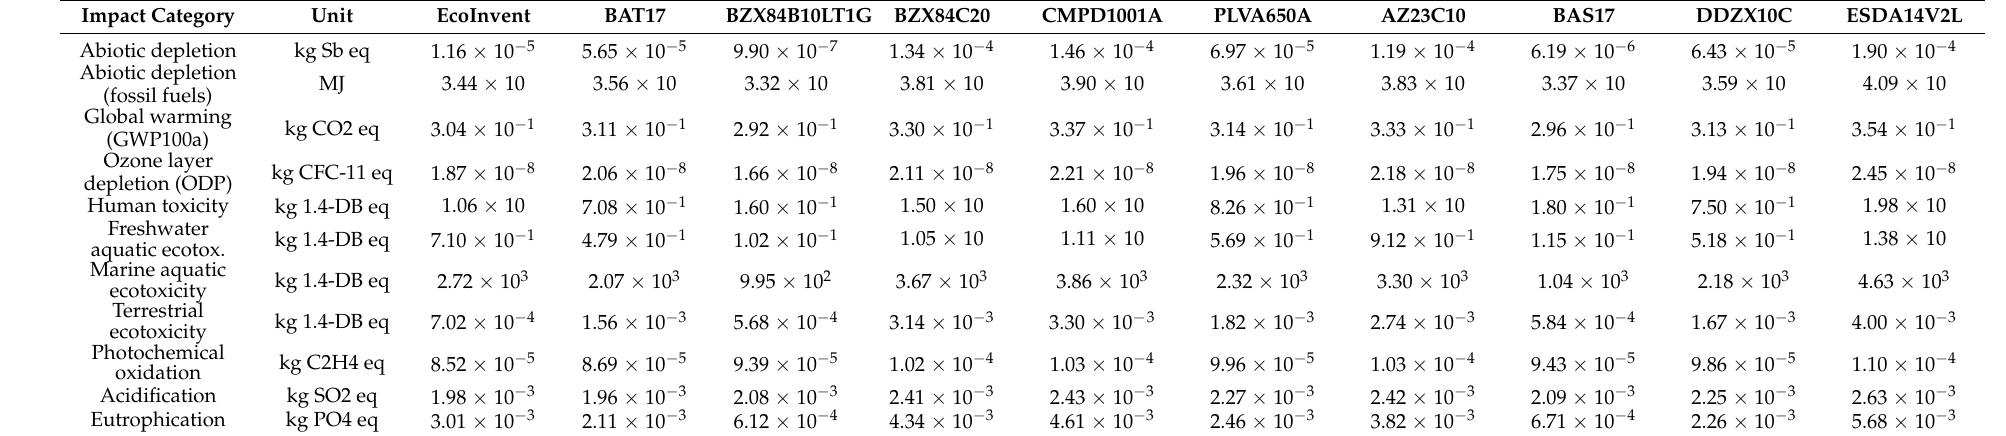
Table 3. Environmental impact of all studied